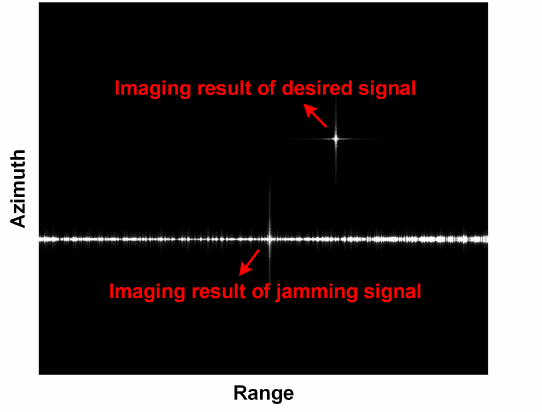
Figure 4. Imaging result of point targets.